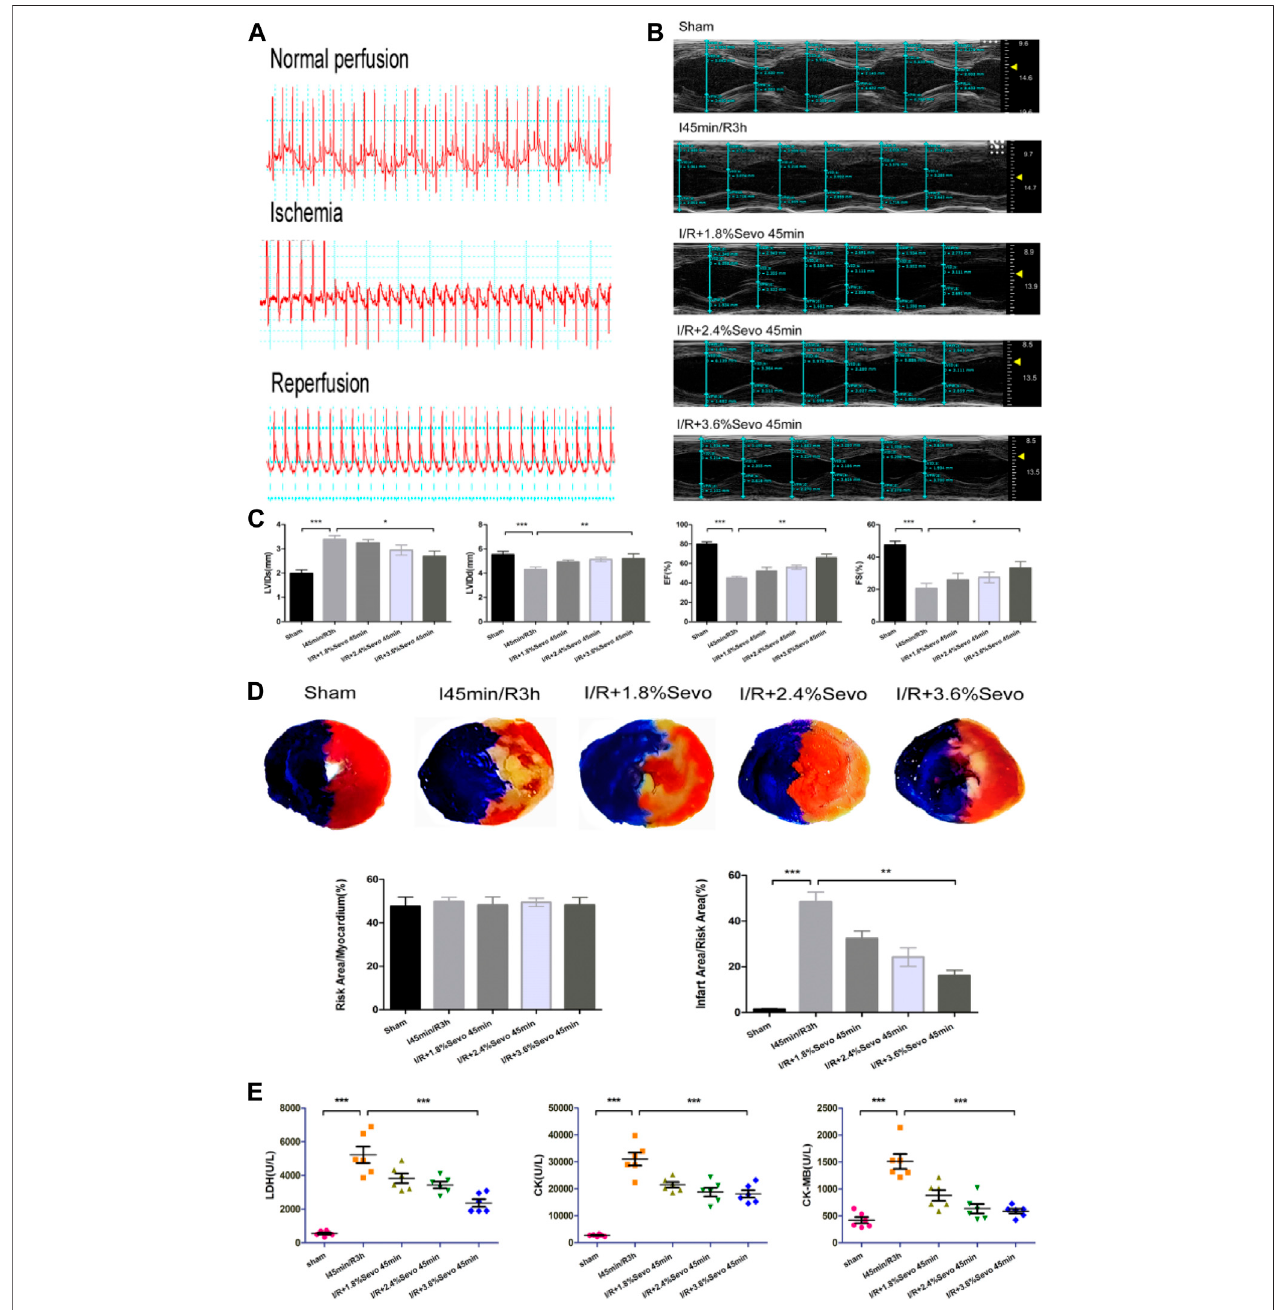
FIGURE3| Sevo fl uranealleviatesMIRIinrats (A) Typicalelectrocardiogramofnormalperfusion,ligationofLADandreperfusion (B) Cardiacultrasonographyinrats of normal perfusion, MIRI and treatment with different concentrations of sevo fl urane (C) Histogram of rat cardiac ultrasonography (D) Myocardial infarction area and histogram of rats treated with different concentrations of sevo fl urane (E) Effects of Sevo fl urane at different concentrations on the release of LDH, CK and CK-MB in myocardial tissue after MIRI. Data are expressed relative to the mean value of sham group and were presented as mean ± SD (n (cid:1) 6). * p < 0.05, ** p < 0.01, *** p < 0.001 vs respective